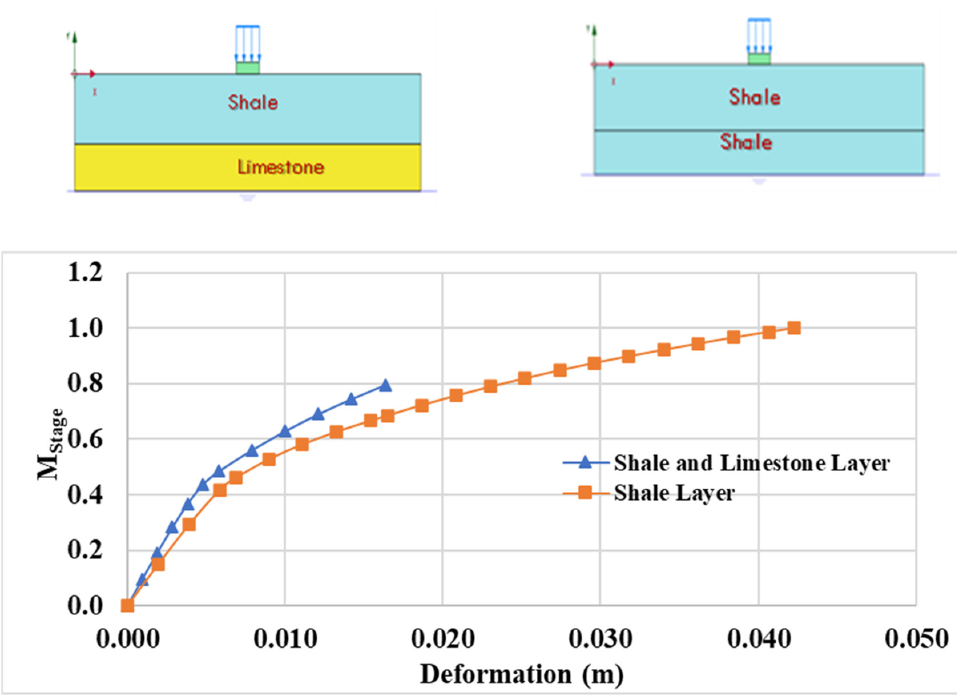
Figure 9. Interface between the shale and limestone layers.